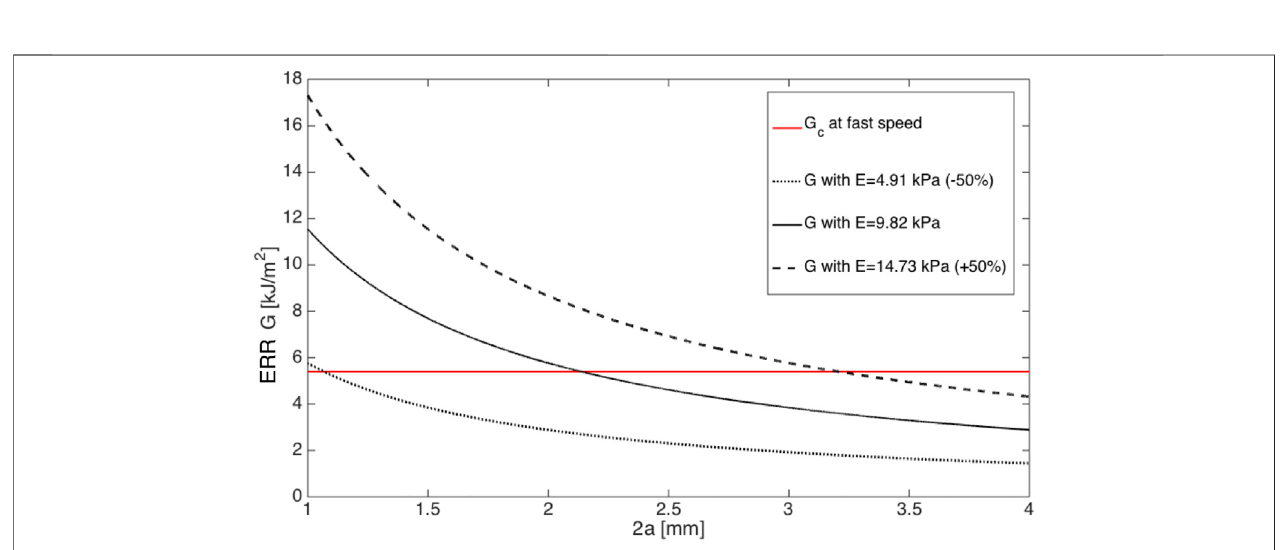
FIGURE 4 | ERRs plotted against the incision length 2 a in ±50 % moduli at fast incision speed. Note that G c is plotted as a reference.